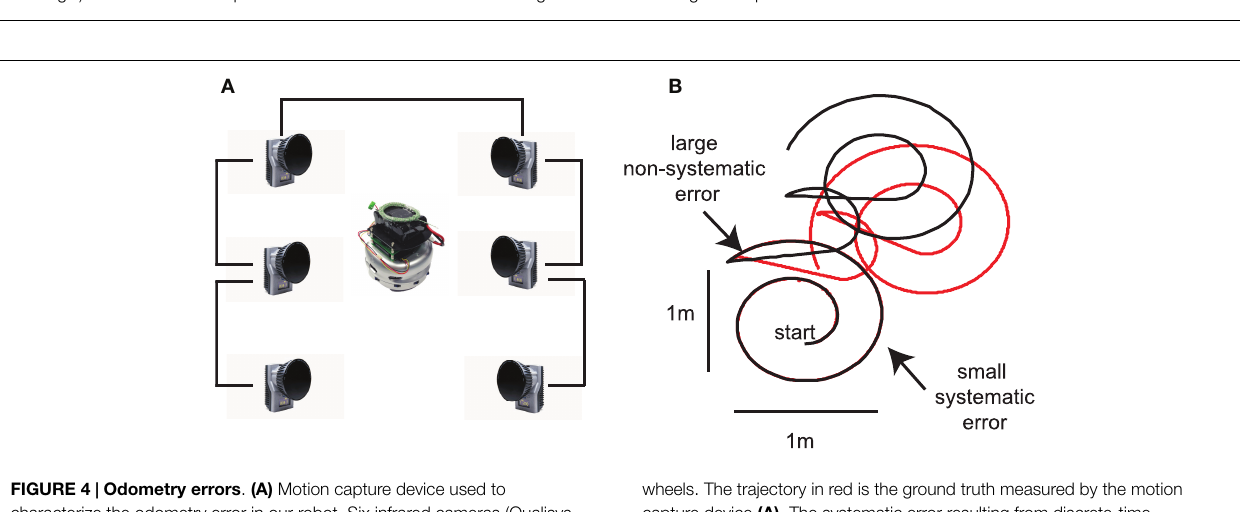
FIGURE 3 | Limited space perception with smoke . (A) LIDAR sensor ( ± 120° detection range) mounted on a Khepera robot. (B) Experiments with the robot placed in a closed chamber (dashed rectangle). Black and colored points are measurements obtained during